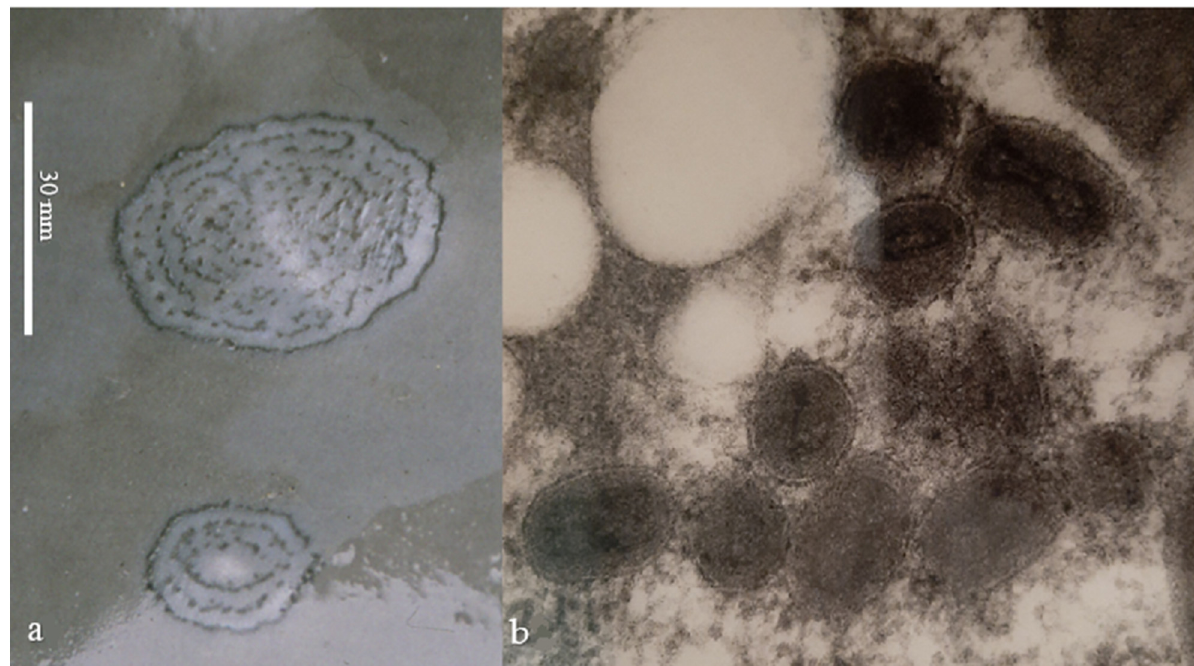
Figure 1. ( a ) Typical tattoo skin lesions in inshore common bottlenose dolphin ( Tursiops truncatus ) MFB-465; ( b ) poxvirus particles in skin lesions of offshore T. truncatus (MFB-187) from central Peru (Magnification ≅ × 180.000).